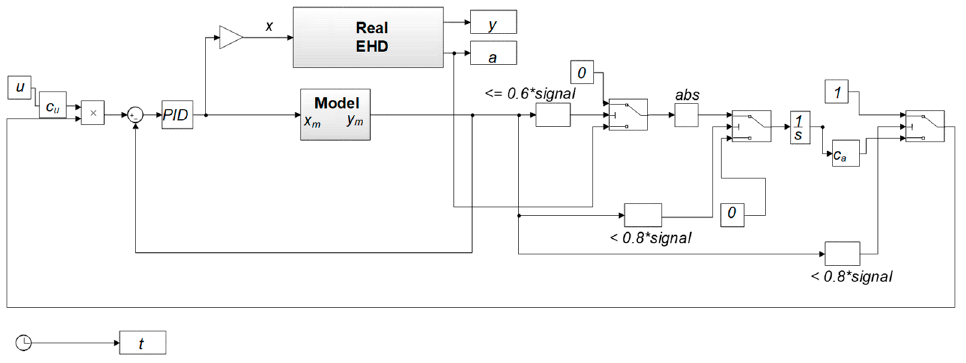
Figure 4. Simulation model of the drive and control system (EHD—electrohydraulic